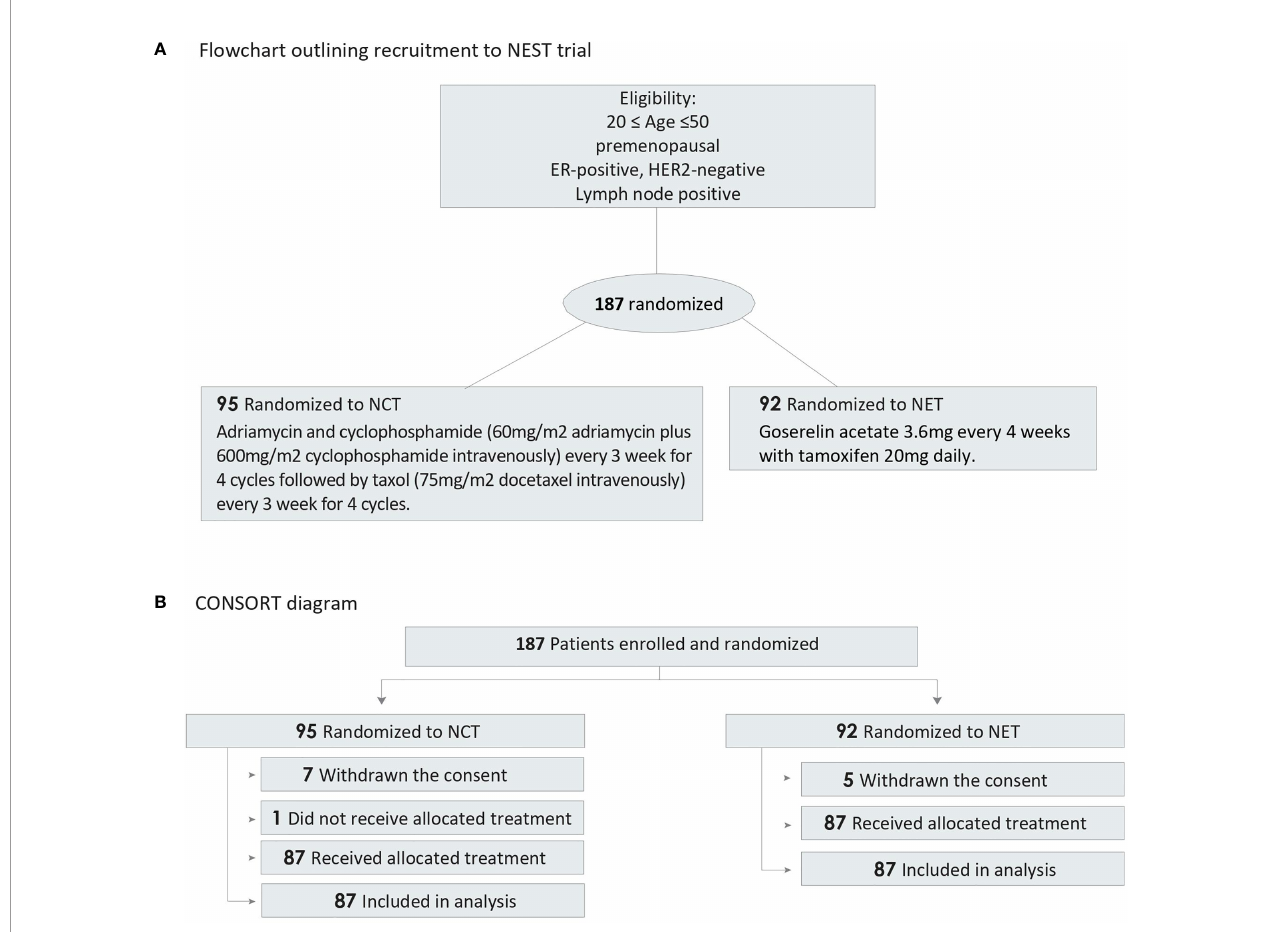
FIGURE 1 | Flowchart and CONSORT Diagram. ER, estrogen receptor; HER2, human epidermal growth factor receptor 2; NCT, neoadjuvant chemotherapy; NET, neoadjuvant endocrine therapy. (A) Flowchart outlining recruitment to NEST trial, (B) CONSORT diagram of participant